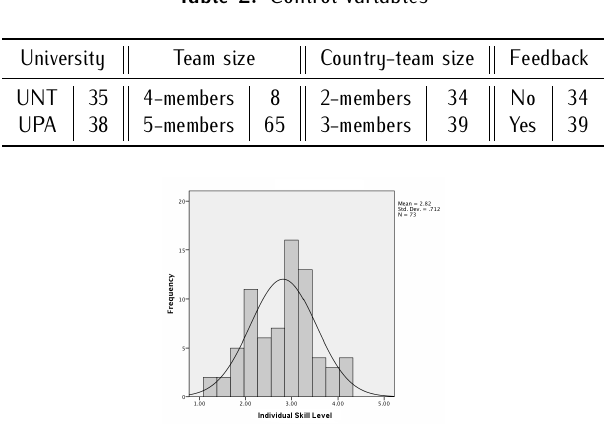
Figure 3. Individual Skill Level distribution.